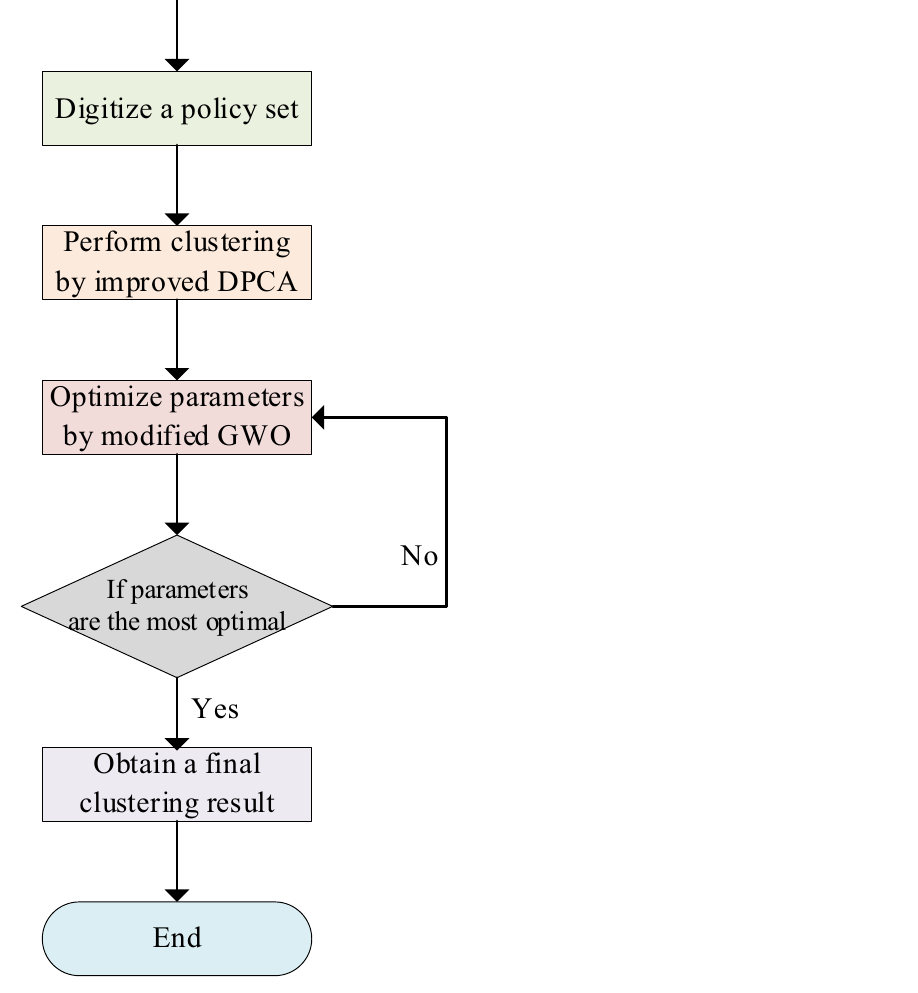
Figure 2. Clustering process of an improved